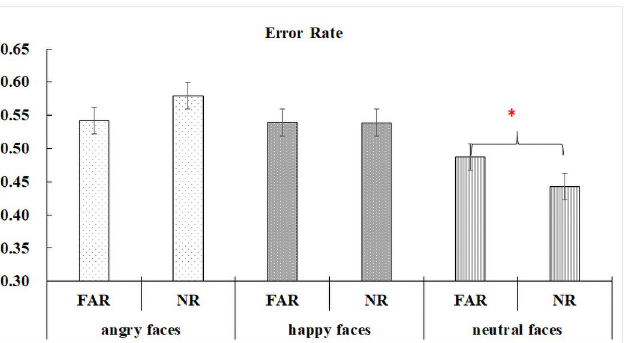
Fig 3. Interaction effects between angry and neutral face distractor conditions on distractor position error rate differences for all participants.